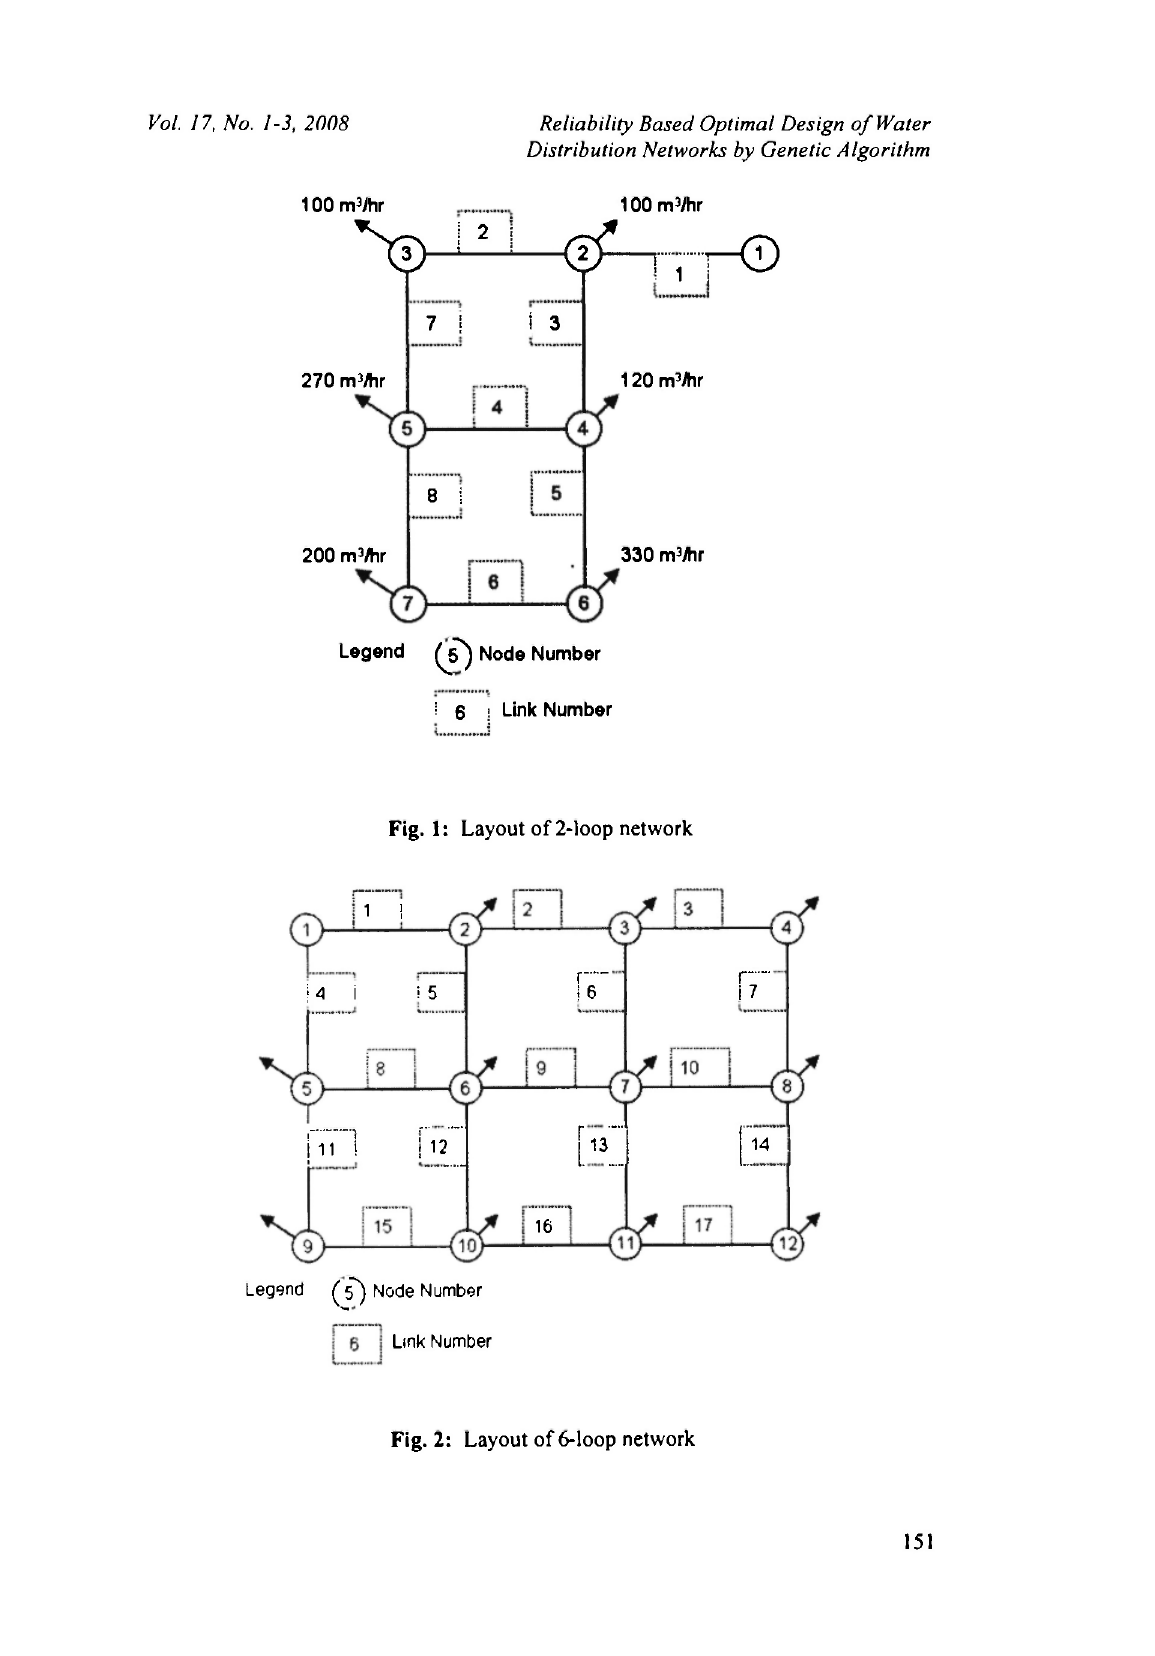
Fig. 1: Layout of 2-loop network